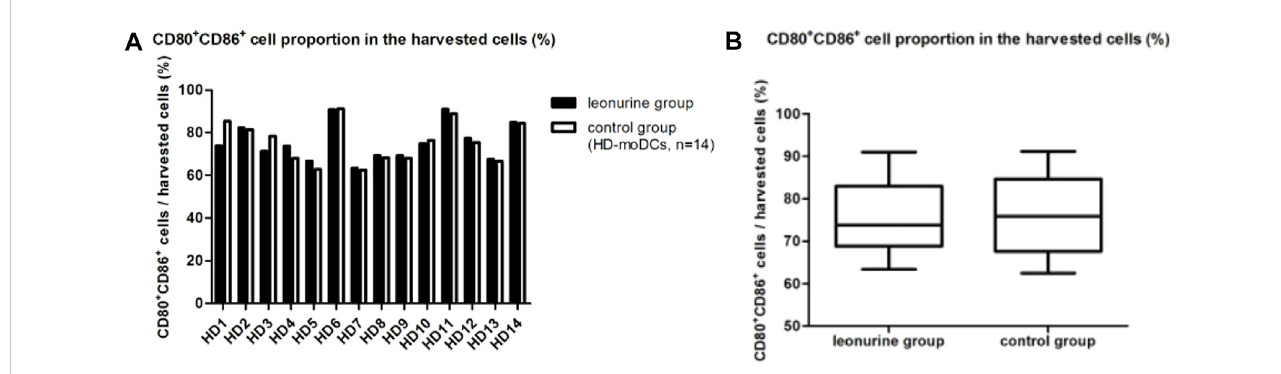
The proportion of moDCs (CD80 + CD86 + cells) in the harvested cells between the leonurine group and the control group (HD-moDCs, n = 14). (A) The graph shows the proportion of moDCs in the harvested cells between the leonurine group and the control group for each HD. (B) The boxplot shows that when moDCs derived from all 14 HDs were analyzed together, there was no statistical difference in the proportion of moDCs in the harvested cells between the leonurine group and the control group (75.45% ± 8.79% vs. 75.55% ± 9.69%, p = 0.300, paired-sample Wilcoxon signed-rank